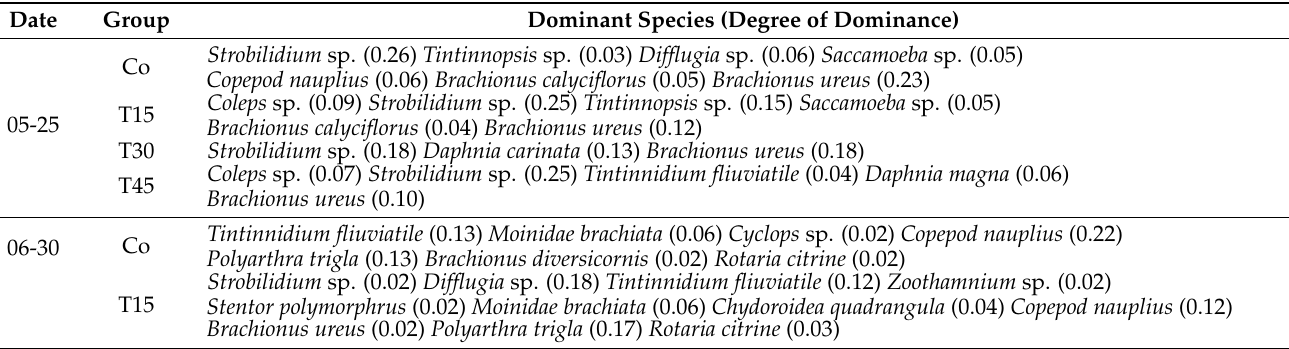
Table A7. Composition of the predominant zooplankton species in the enclosures of each treatment group ( n =